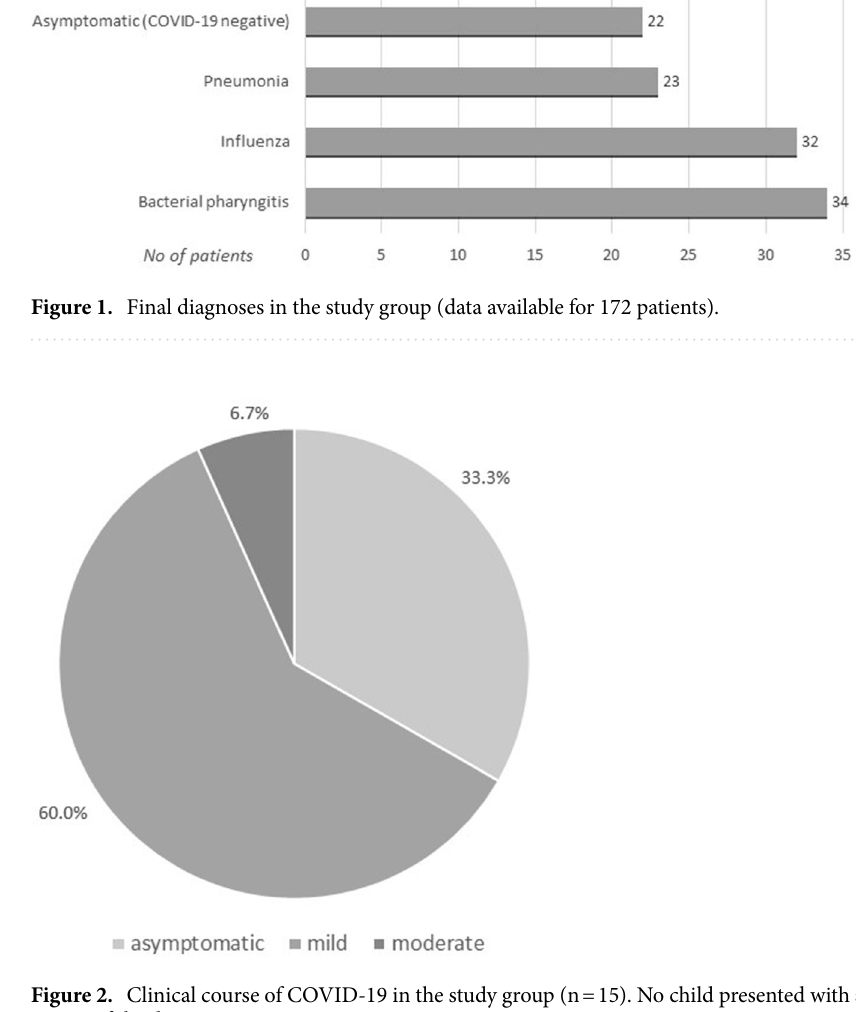
Figure 2. Clinical course of COVID-19 in the study group (n = 15). No child presented with a severe or critical course of the